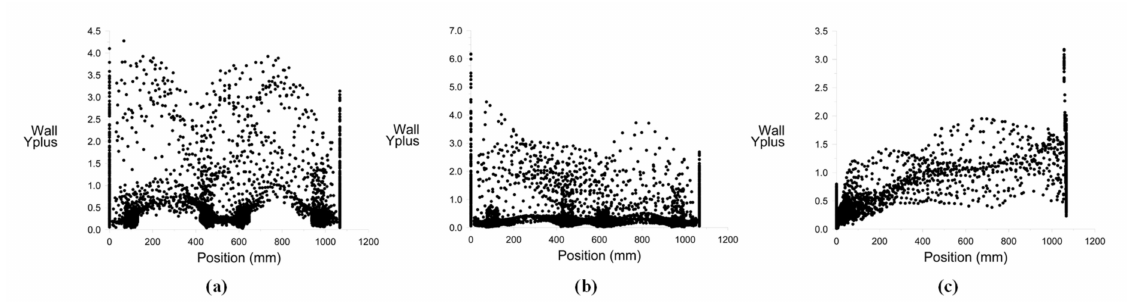
Figure 7. Y + values near the wall. ( a ) Traditional 120 ◦ lower air supply; ( b ) Traditional 45 ◦ upper air supply; ( c ) New air cooling system.